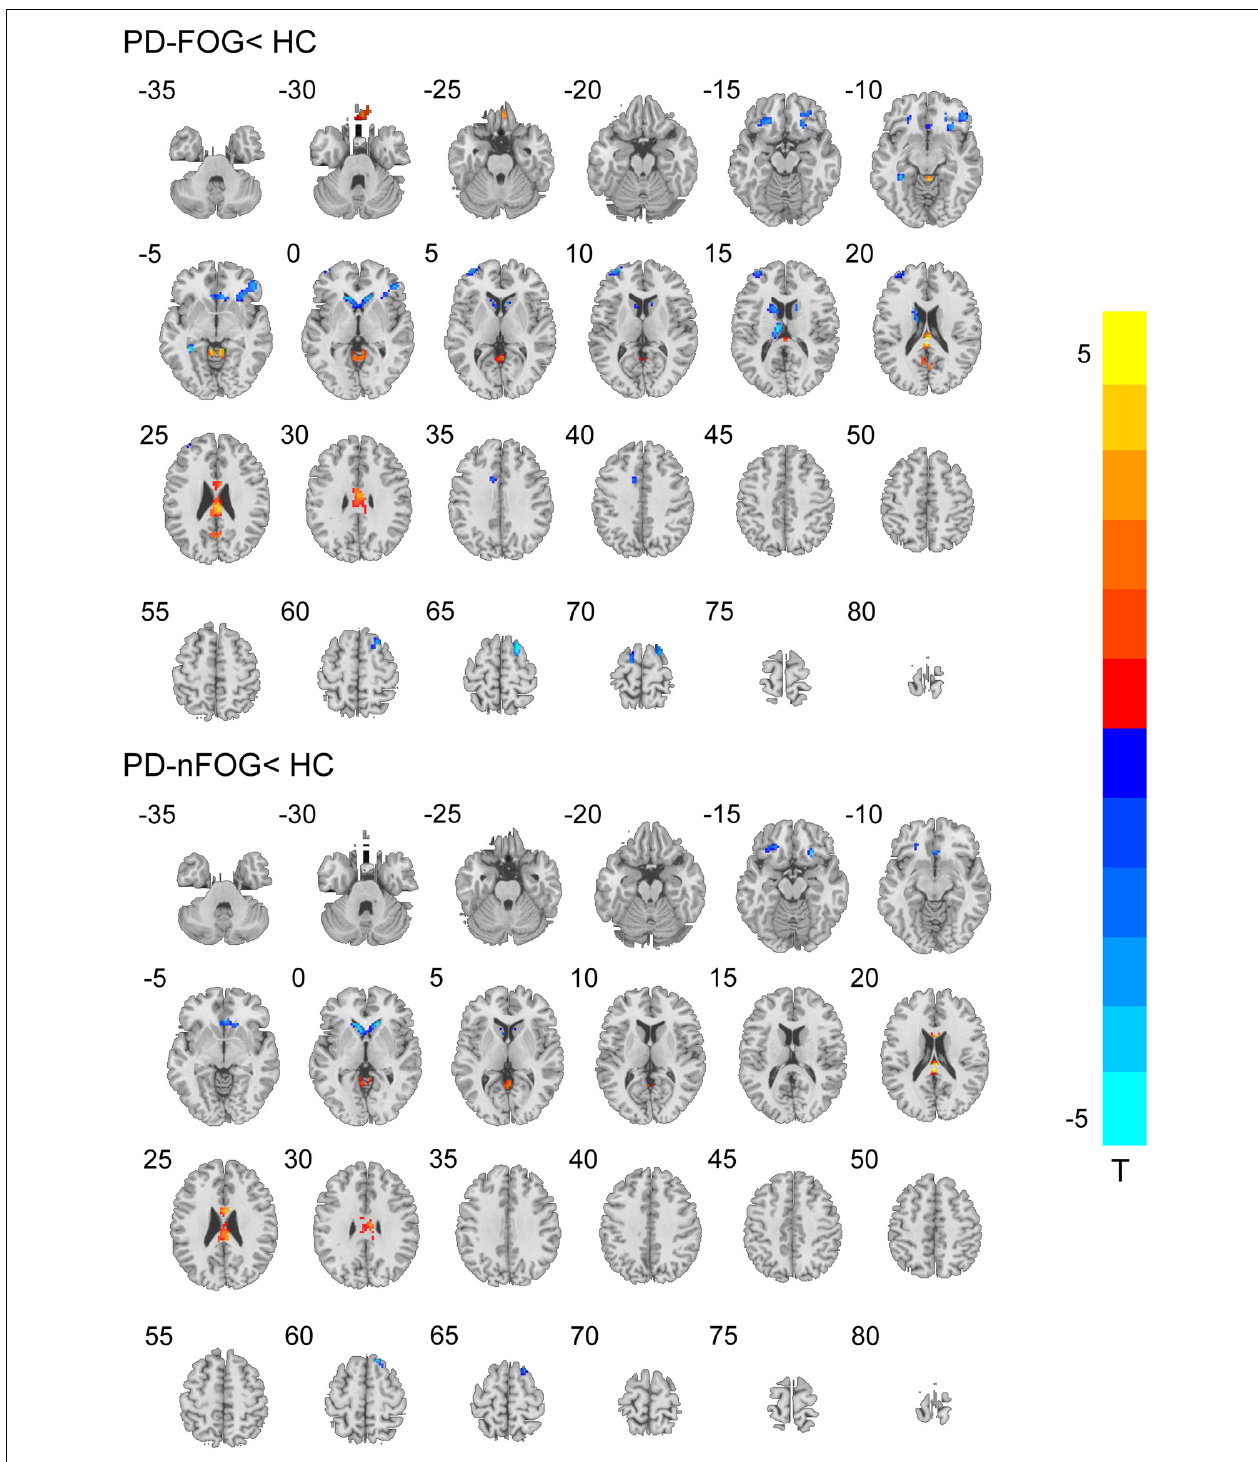
FIGURE 3 | Functional connectivity (FC) from RMFG to the other brain regions. Red and blue indicate increased and decreased FC, respectively, in the PD-FOG and PD-nFOG groups when compared with HC. Differences were considered significant at p < 0.001 (AlphaSim-corrected).